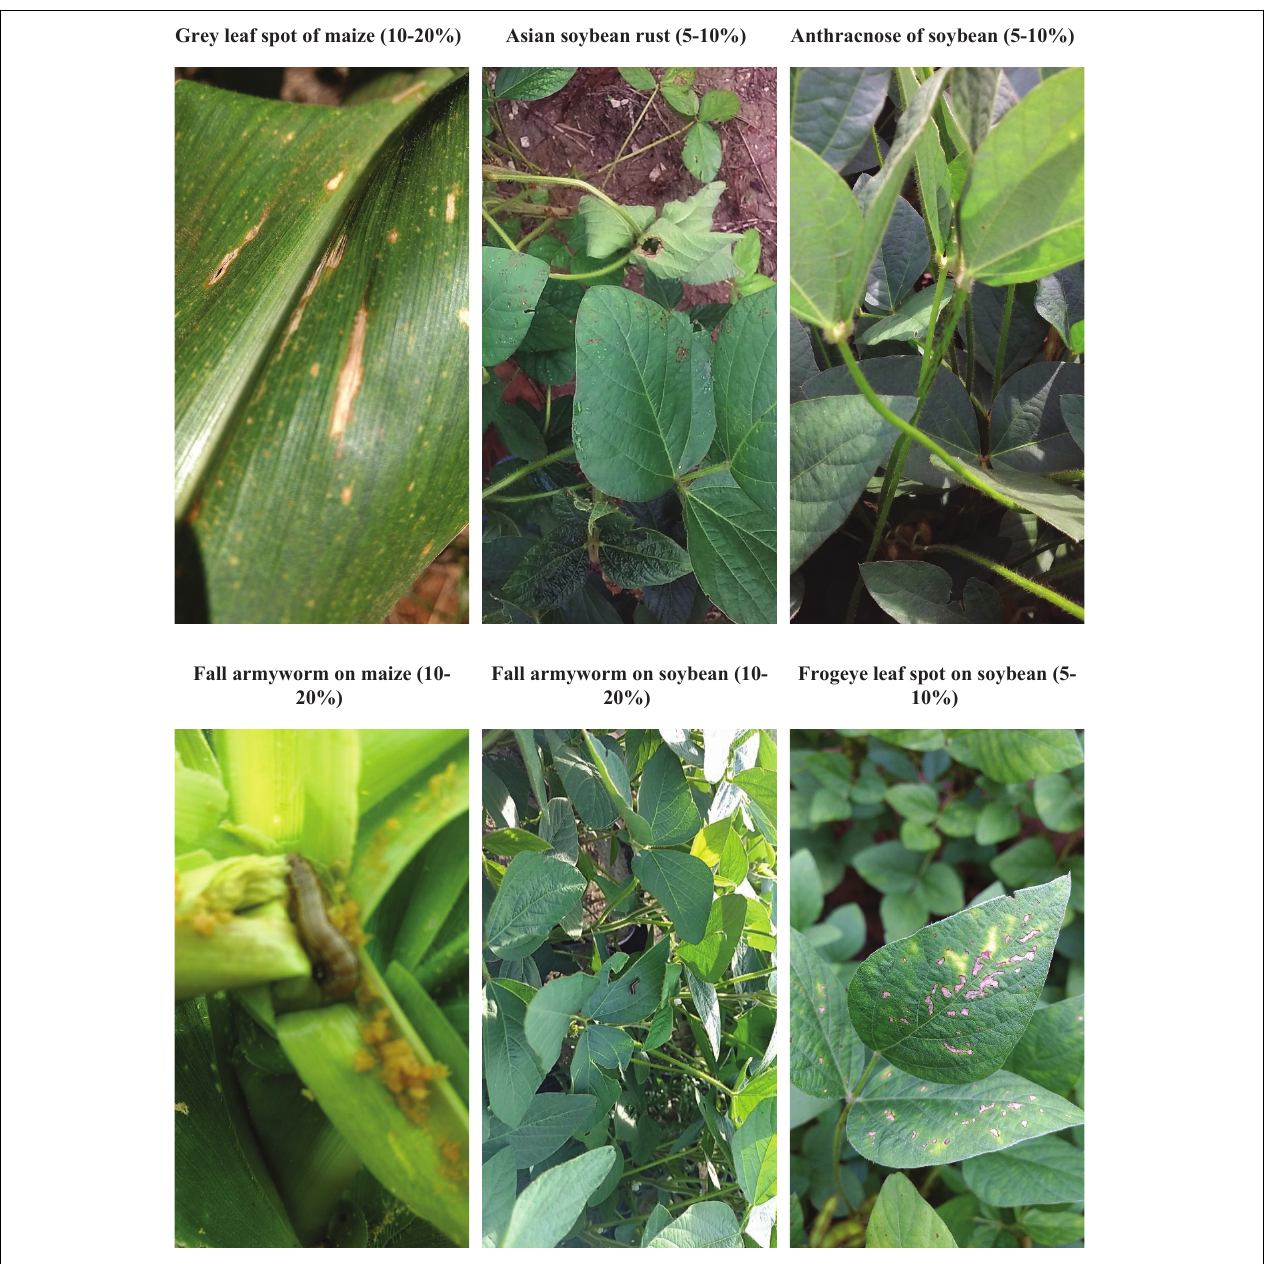
FIGURE 9 | Examples of images of diseased soybean and maize plants and associated expected yield losses provided by agronomists in the state of MT, Brazil, in the 2016–2017 cropping